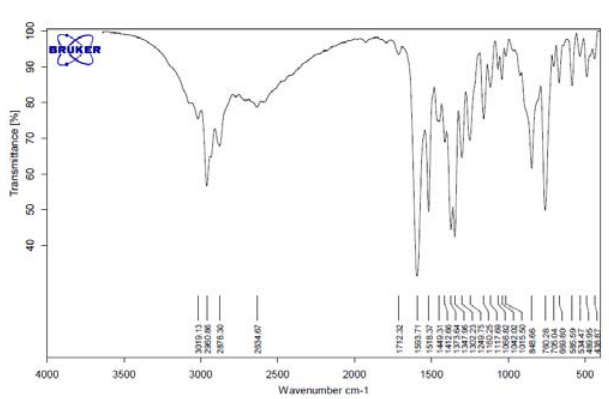
Fig. 6: FTIR spectrum of the